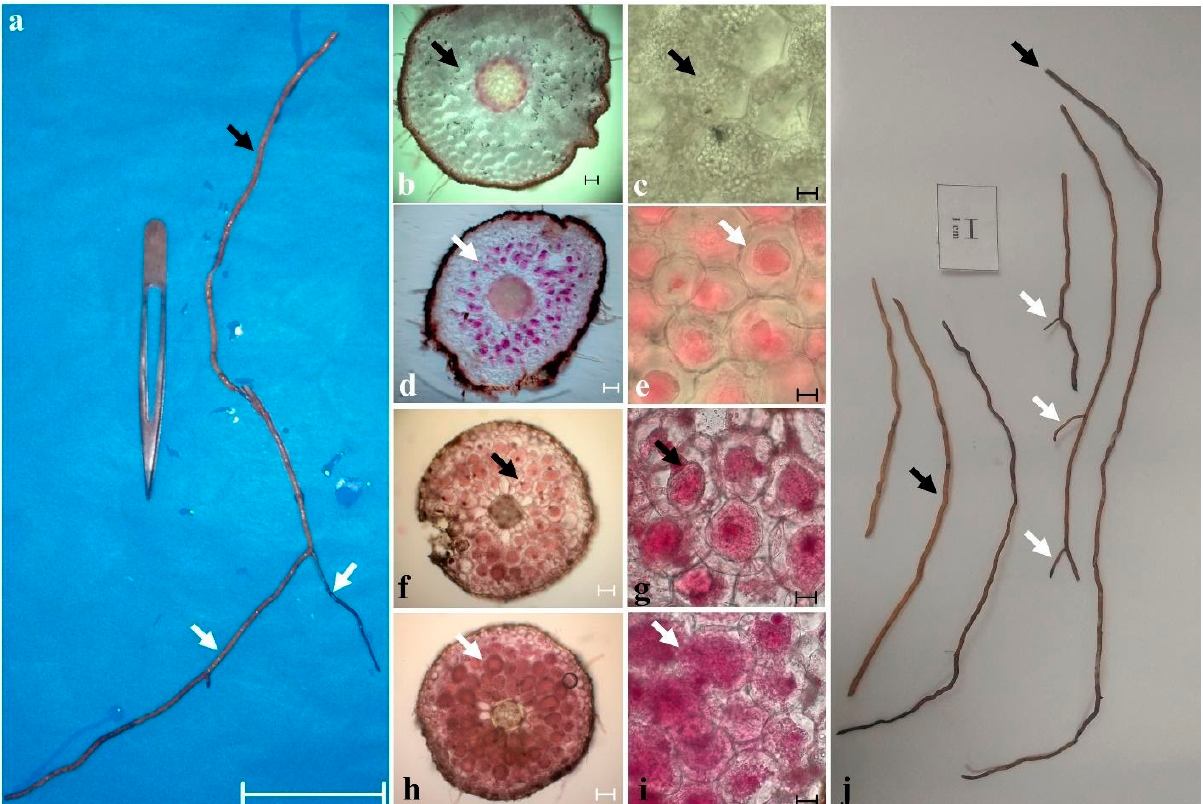
Figure 7. Mycorrhizal root colonization of Mesoamerican Cypripedium . View of one of the main roots (black arrows) and secondary roots (white arrows) of Cypripedium irapeanum ( a – e ) and C. molle ( f – j ). Cortical colonization by mycorrhizal fungi occurs in patches on the main roots with long sections without fungal colonization and starch grains ( b , c ) and some with very dense colonization with digested pelotons ( f , g ). SR are always densely colonized with undigested and partially digested pelotons ( d , e and h , i ). Bars in c, e, g, i = 10 µm and bars in b, d, f, h = 100 µm. Bar in a = 10 cm. Photos taken by Mauricio Moreno in year 2019.